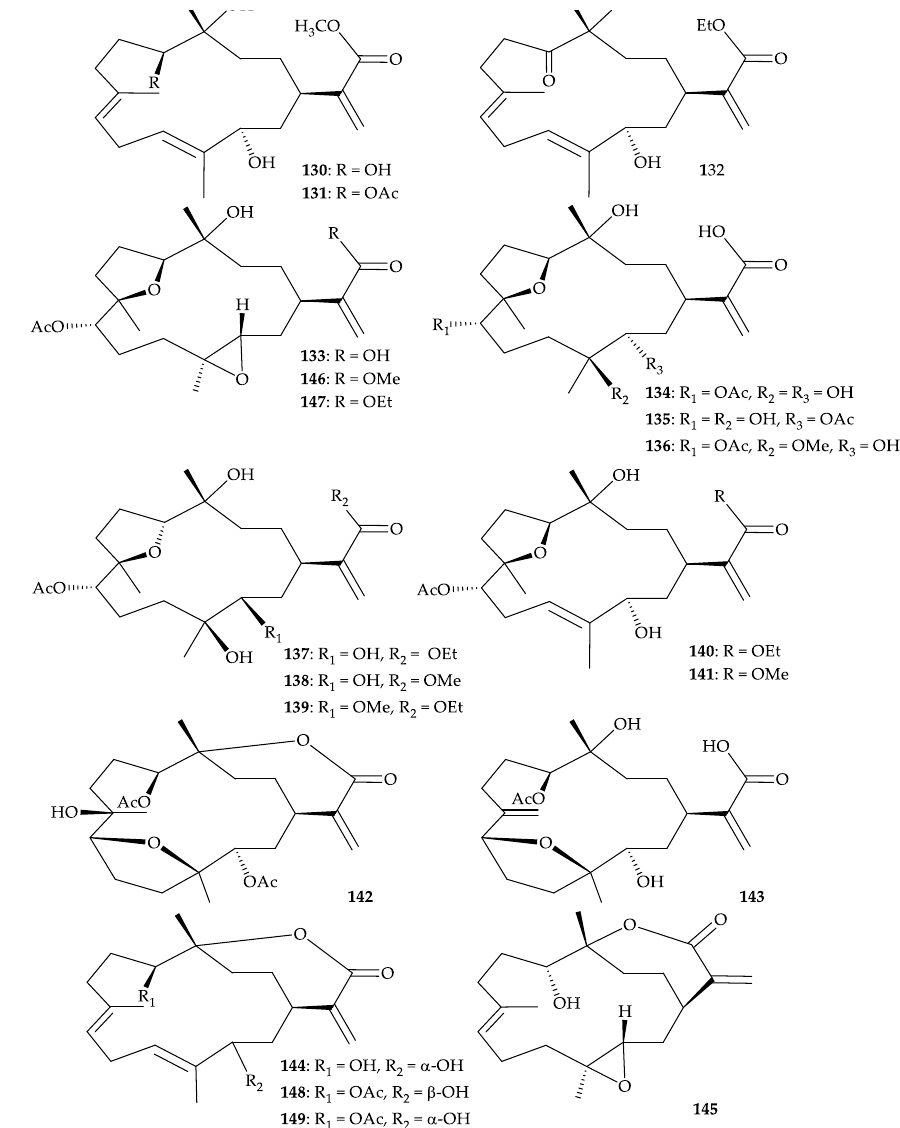
Figure 22. Structures of dendronpholides C–F ( 130 – 133 ), I–R ( 134 – 143 ), ( − )-sandensolide ( 144 ), 11- episinulariolide ( 145 ) and sinulaflexiolides E, F, J, K ( 146 – 149 ). In 2010, two tetrahydroxylated sterols, including a new compound, 23-nor-ergost-24-ene- 3β,5α,6β,7β-tetrol ( 150 ) and a known analogue, ergost-24-ene-3β,6β,9α,19β-tetrol ( 151 ) [131], were isolated from Dendronephthya sp. collected from Naozhou Islands of the South China Sea [132] (Figure